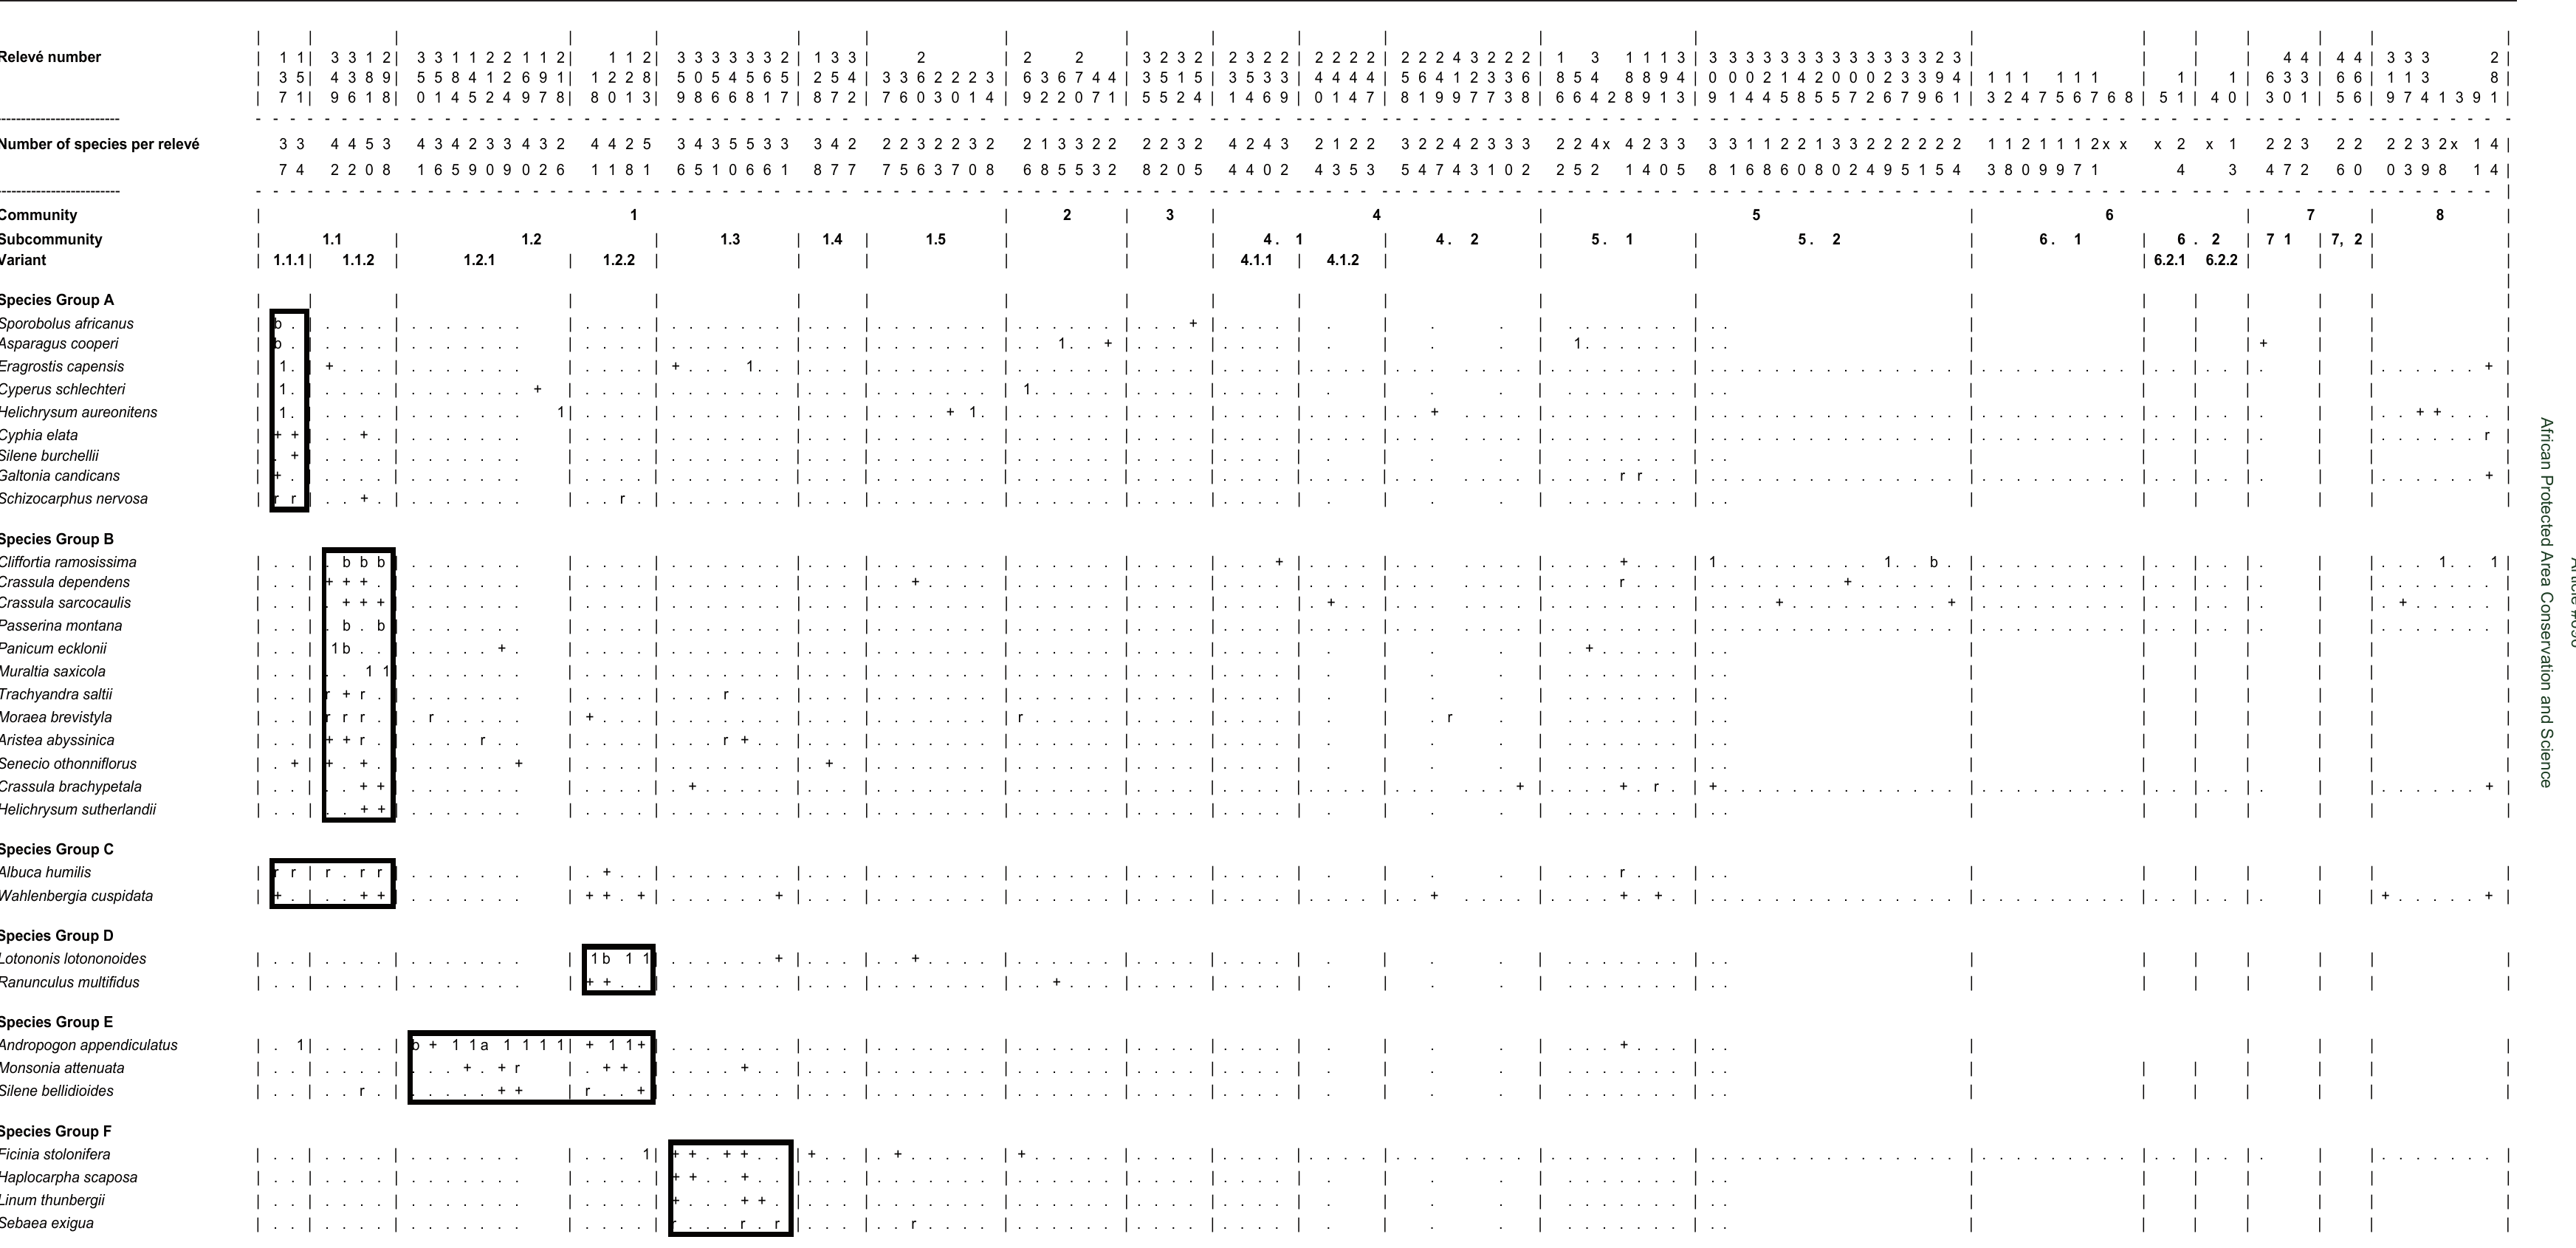
TABLE 1 Phytosociological table for the shrubland communities of